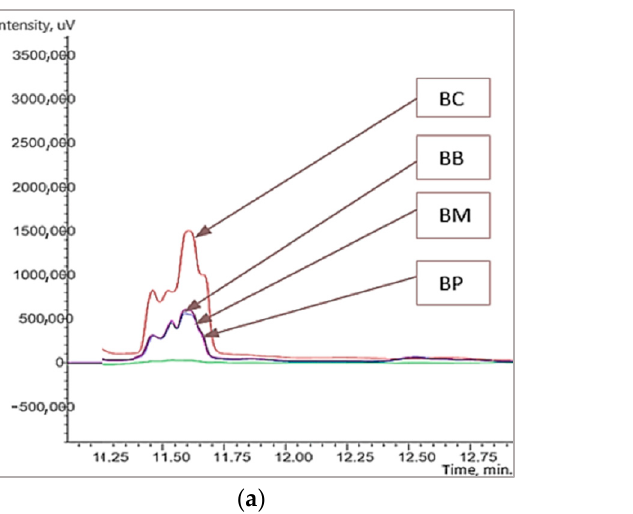
10 of 14 Figure 6. HPLC chromatogram of gliadin fraction of wheat bran samples treated with bromelain 4 h at 45 °C. Proteins that were not retained by the column eluted first (up to 5 min), followed by the fractions of wheat gliadins in the order of hydrophobicity: ω -gliadins, mixed α , β - gliadin fraction, and γ -gliadins. Hydrolysed peptides eluted between 17 and 48 min with the highest fraction observed at 20–26 min. Significant differences were observed between the chromatograms of the gliadin fractions of the wheat bran control and those treated with different enzymes. For a more detailed analysis of the peak intensities, chromato- grams were analysed in “overlay mode”. First, when comparing the chromatograms of the wheat bran control sample and enzymatically digested gliadins, a difference was ob-